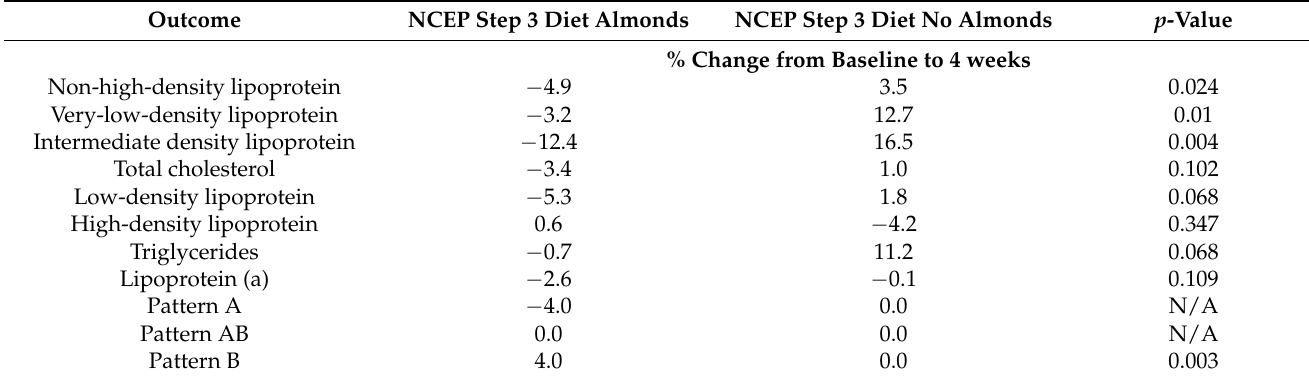
Table 5. Changes in blood lipids from baseline: National Cholesterol Education Program (NCEP) Step 3 diet with almonds vs. without almonds in subjects with statin therapy